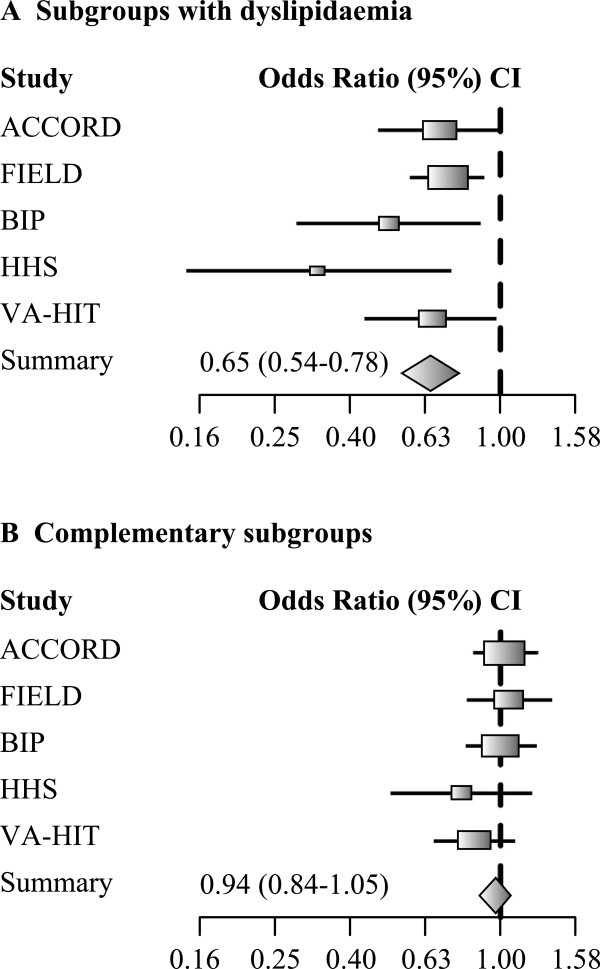
Meta-analysis of major fibrate outcomes studies, showing the impact of fibrate treatment on residual CV risk in patients with atherogenic dyslipidaemia. An odds ratio <1 indicated a beneficial therapeutic effect. The two panels show data from subgroups of patients with dyslipidaemia i.e., high levels of triglycerides and low levels of high-density lipoprotein [HDL] cholesterol, Panel A; or from the complementary subgroups without this dyslipidaemia, Panel B. Subgroups with dyslipidaemia defined according to the ACCORD Lipid trial (triglycerides ≥204 mg/dL or 2.3 mmol/L and HDL cholesterol ≤34 mg/dL or 0.9 mmol/L) or closest to these lipid criteria in each of the other trials were used in this analysis. The outcome defined for each individual trial was used. A total of 2,428 fibrate-treated subjects (302 events) and 2,298 placebo-treated subjects (408 events) with dyslipidaemia were included in the analysis reported in A. Reproduced with permission from Sacks et al. [47].